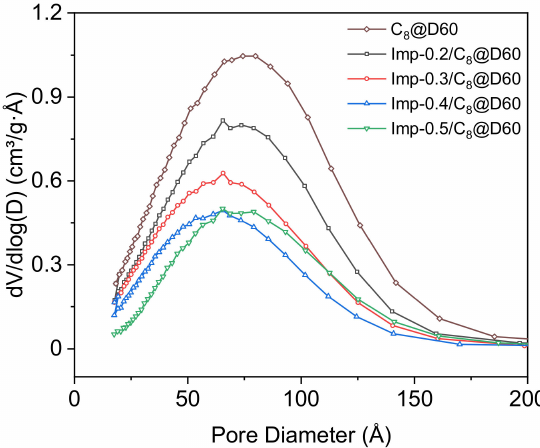
Figure 3. Pore size distributions of the pre-functionalized support (C 8 @D60) and the impregnated